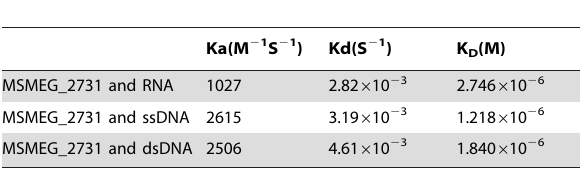
Table 2. Kinetic parameters of interactions between MSMEG_2731 and RNA, ssDNA and dsDNA.